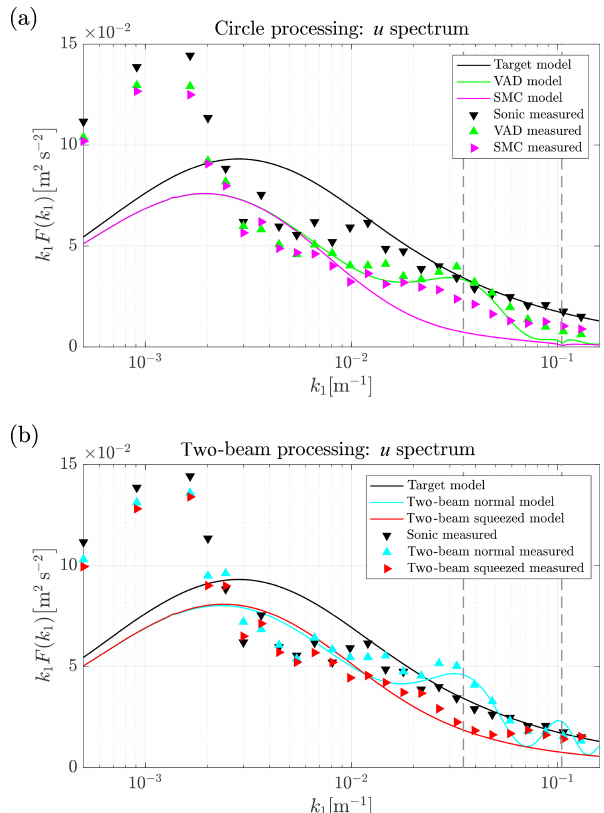
Figure 5. Modeled (solid lines) and measured (triangle markers) u spectra from data processing for which (a) all radial measurements are used and (b) only two beams are used. Colors correspond to the processing method. The grey vertical dashed lines represent the first and second resonance wave